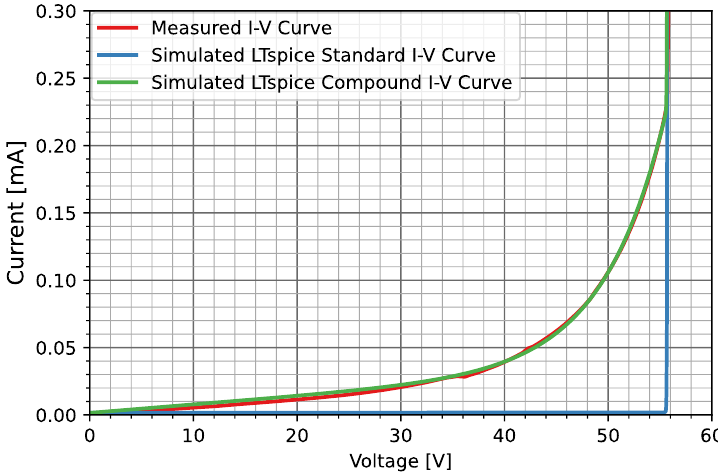
Figure 23. Measured and simulated reverse bias plots for the 15SQ040